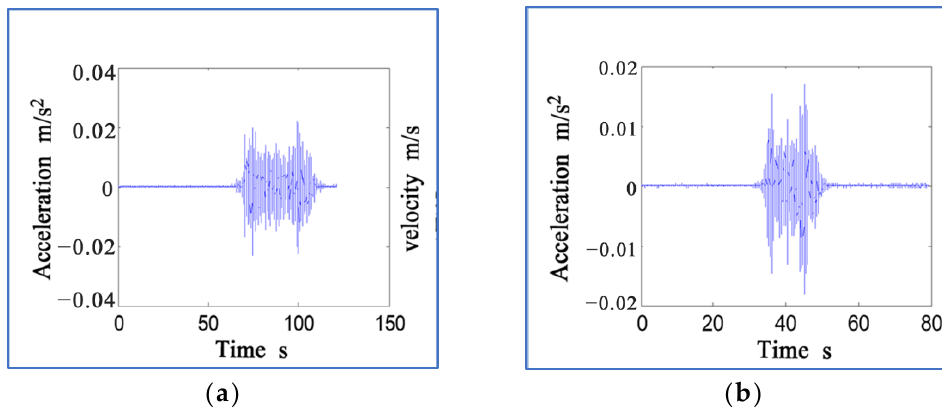
Figure 10. Testing vibration acceleration curve. ( a ) is Speed 60 km/h; ( b ) is Speed 120 km/h. Horizontal vibration acceleration distance attenuation formula: a = 0.145 × e − 0.20s Vertical vibration acceleration attenuation formula: a = 0.031 × e − 0.17s The variation law of the vibration velocity distribution can be obtained by the convo- lution and integration of the vibration acceleration, as shown in Figure 11.